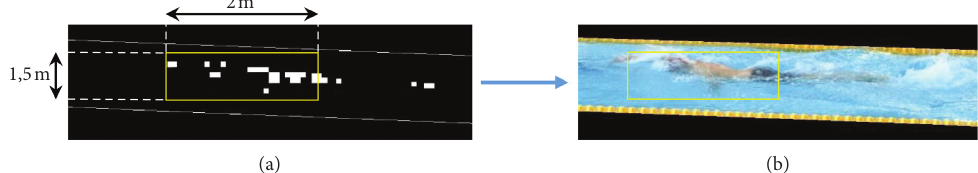
Figure 15: Localization of the region of interest. (a) Difference image decomposed into blocs and thresholded. The rectangle represents the region of interest centered according to the lane width, starting with the first bloc corresponding to the swimmer motion. (b) Projection of the rectangle on the original image. Swimming Championships in Limoges, France, April 2015. Table 2: Region of interest localization percentage using method a contrario with and without prediction. Crawl-Swimming Cham- pionships in Limoges, France, April